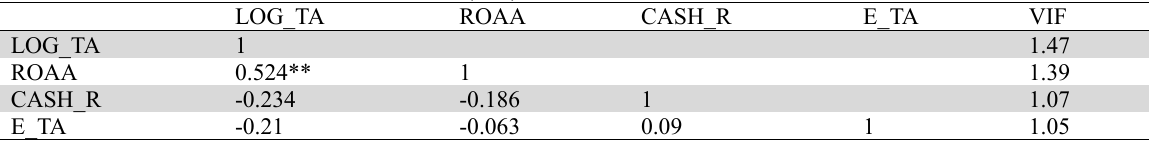
Correlation Matrix and Variance Inflation Factor (VIF)